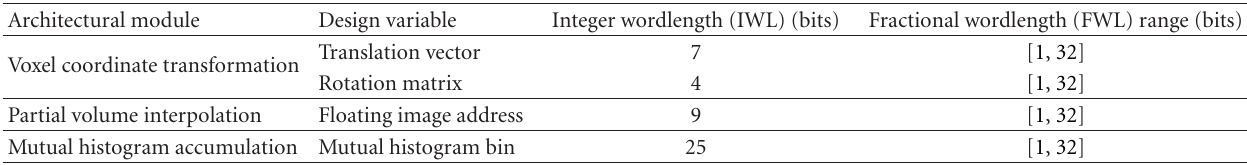
Table 1: Design variables for FPGA-based architecture. Integer wordlengths are determined based on application-specific range information, and fractional wordlengths are used as parameters in the multiobjective optimization